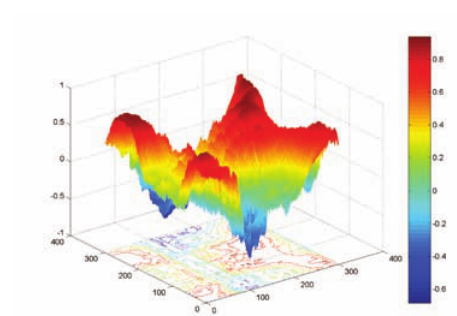
Fig. 1. Section of the eye